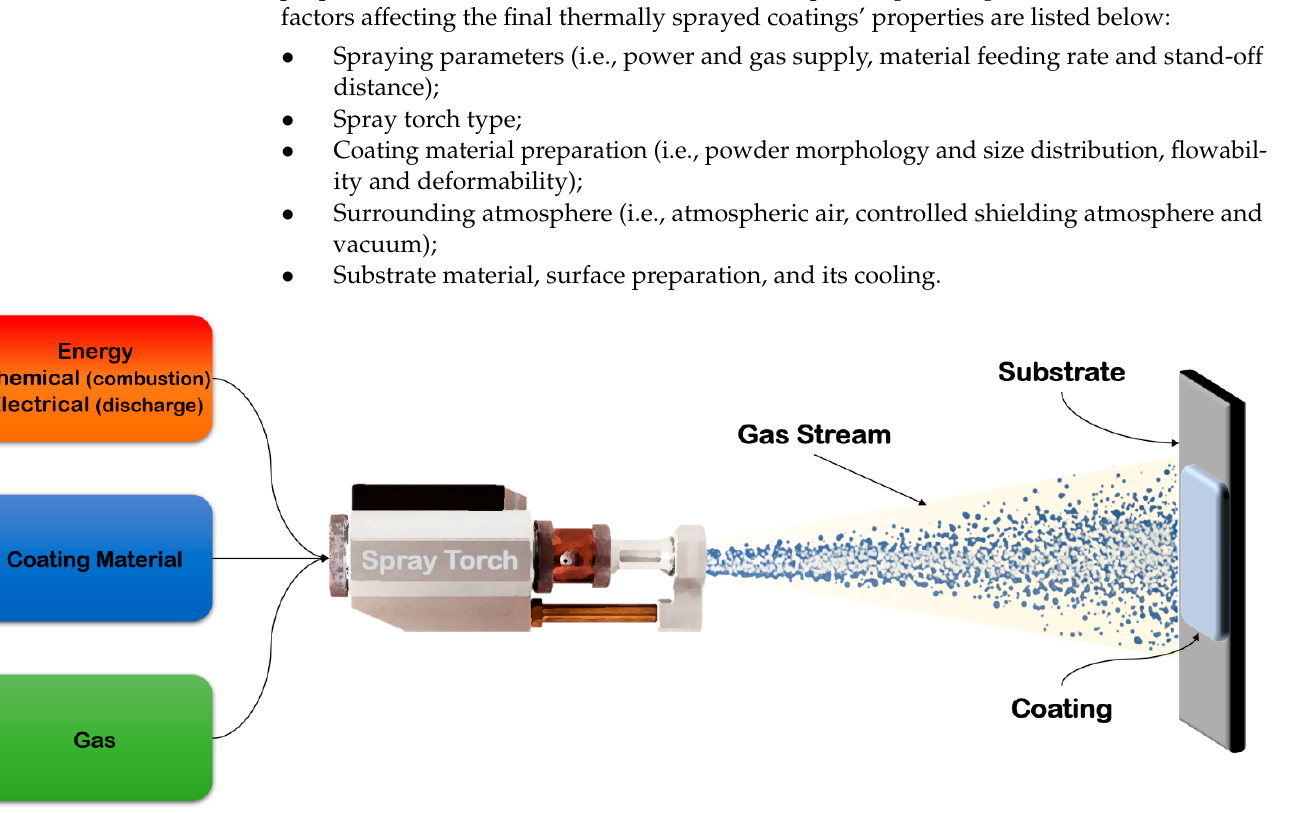
Figure 5. Schematic representing the thermal spray concept.